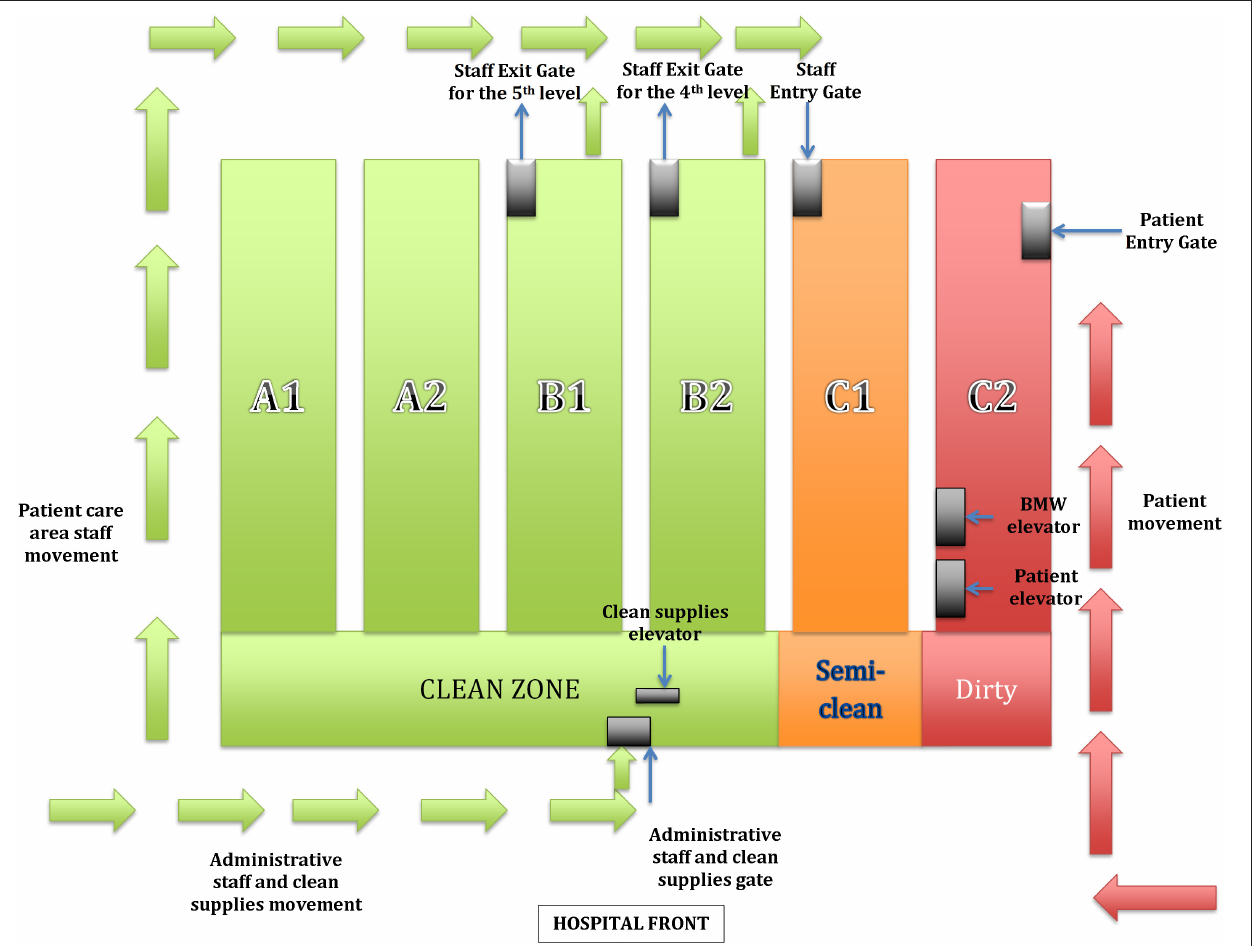
FIGURE 2 | A schematic representation of the functioning of the transformed hospital. A clear demarcation between the clean and contaminated zone can be appreciated in the